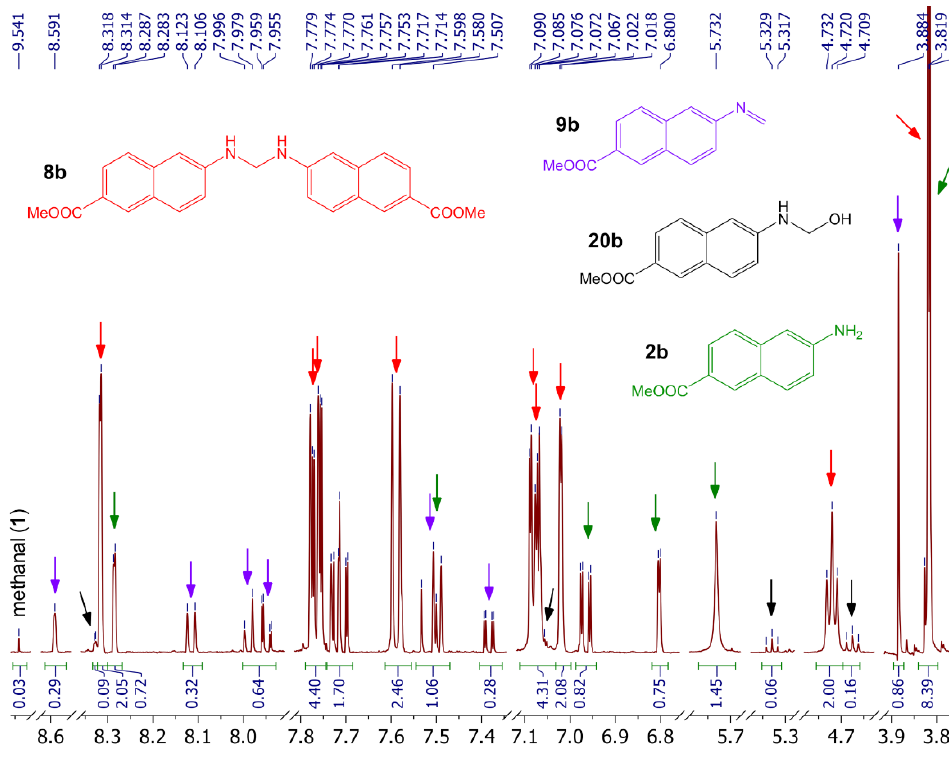
Figure 1. The 1 H NMR spectrum of the sample containing imine 9b (violet), aminal 8b (red), hemiaminal 20b (black), naphthylamine 2b (green), and methanal ( 1